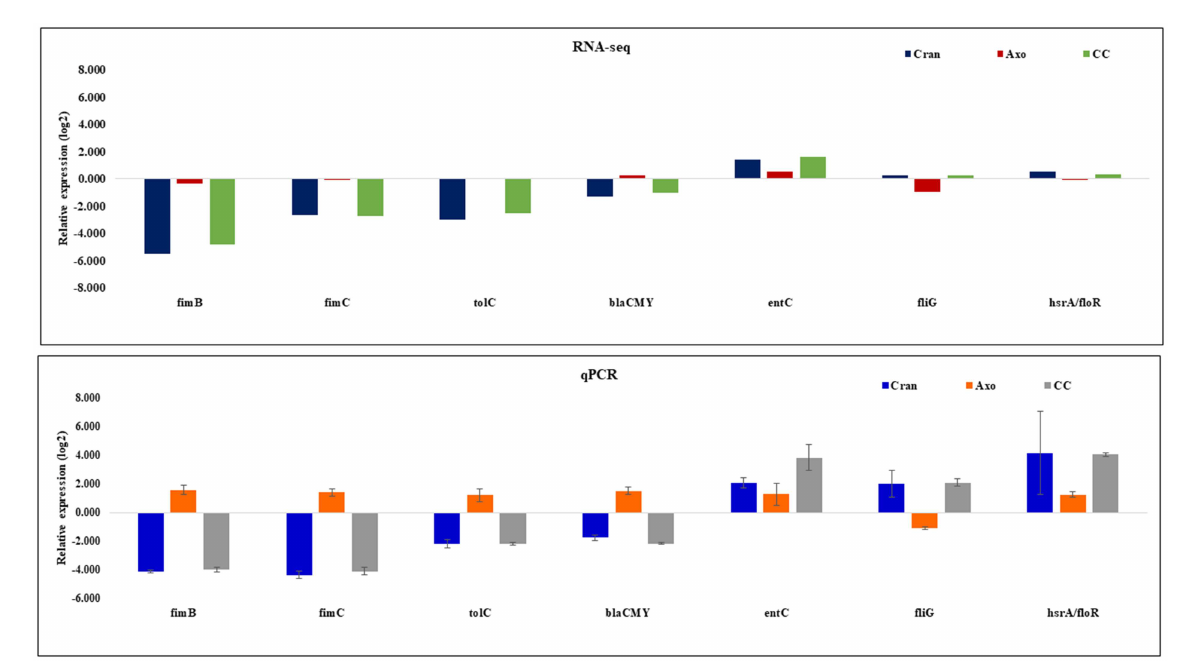
FIGURE8 Validation of the RNA-seq data for selected genes by RT-qPCR. RT-qPCR data confirmed the expression trends observed in the RNA-seq data for seven genes in 4 mg/mL of CRAN, 4 µ g/mL of AXO, and 4 µ g/mL AXO + 4 mg/mL CRAN (CC) compared to control, where rpoD was used as a reference